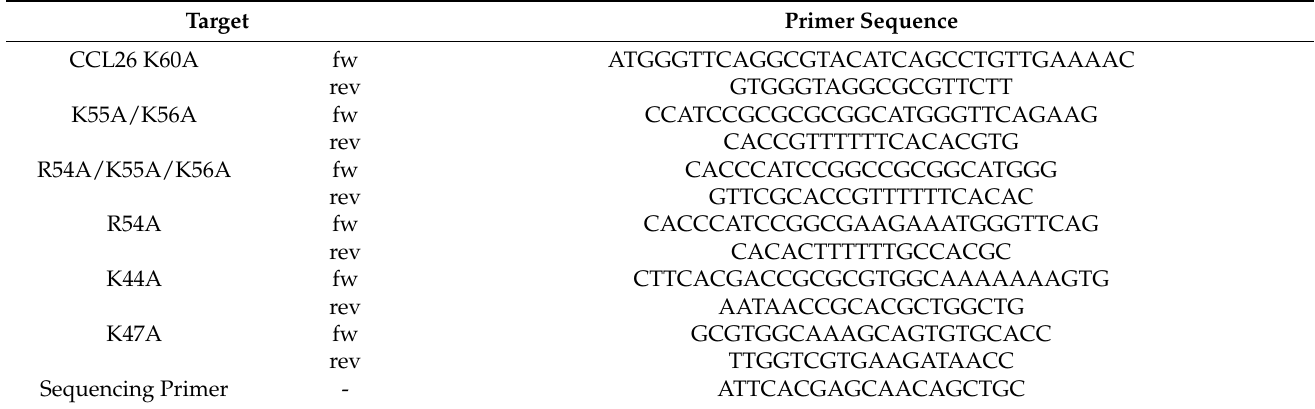
Table 2. List of primer sequences (fw, forward; rev, reversed) used for generating CCL26 mutants by site-directed